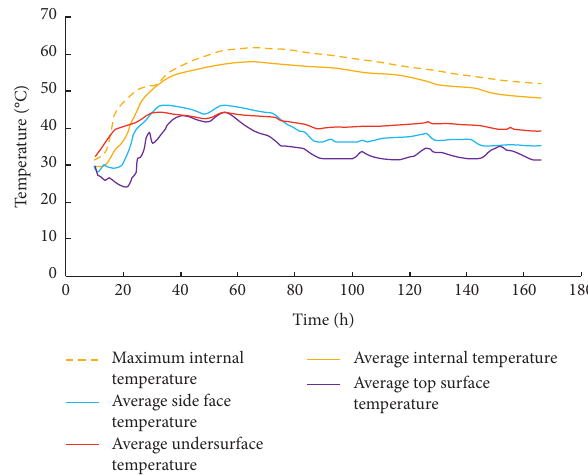
Figure 20: Monitoring results of second pouring temperature of cap. Table 6: Analysis of measured results of cap temperature.